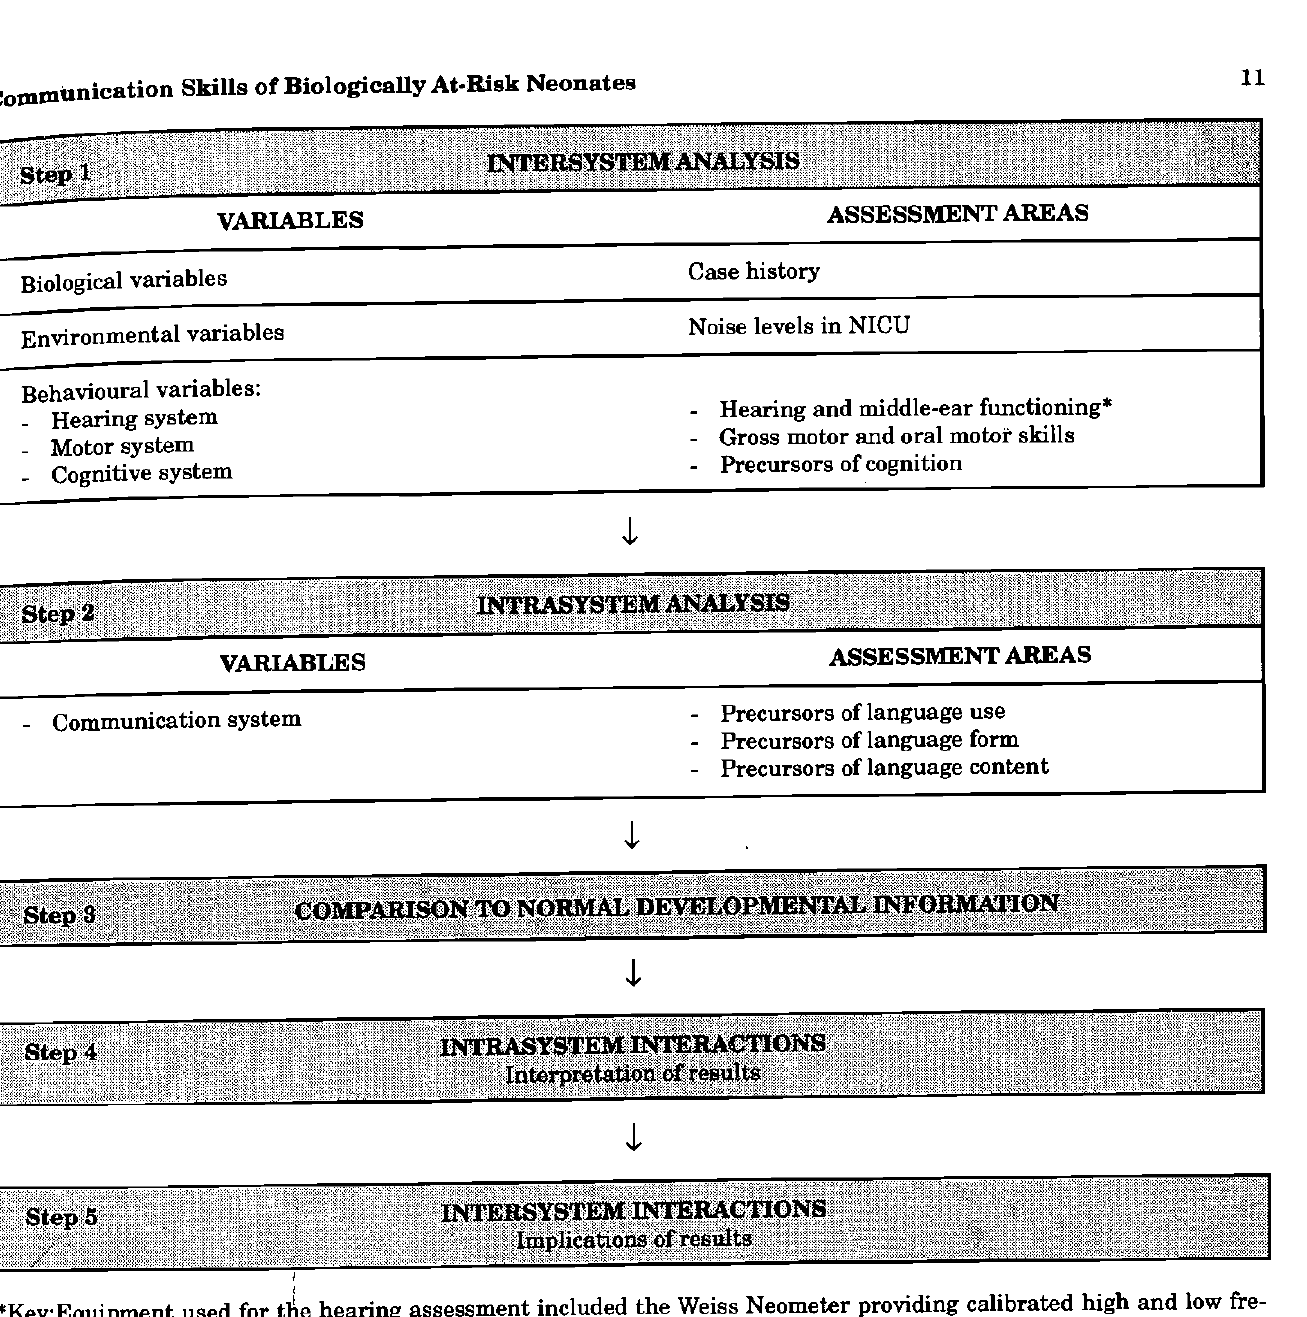
Figure I: Neonatal communication assessment model for biologically at-risk infants RESULTS AND